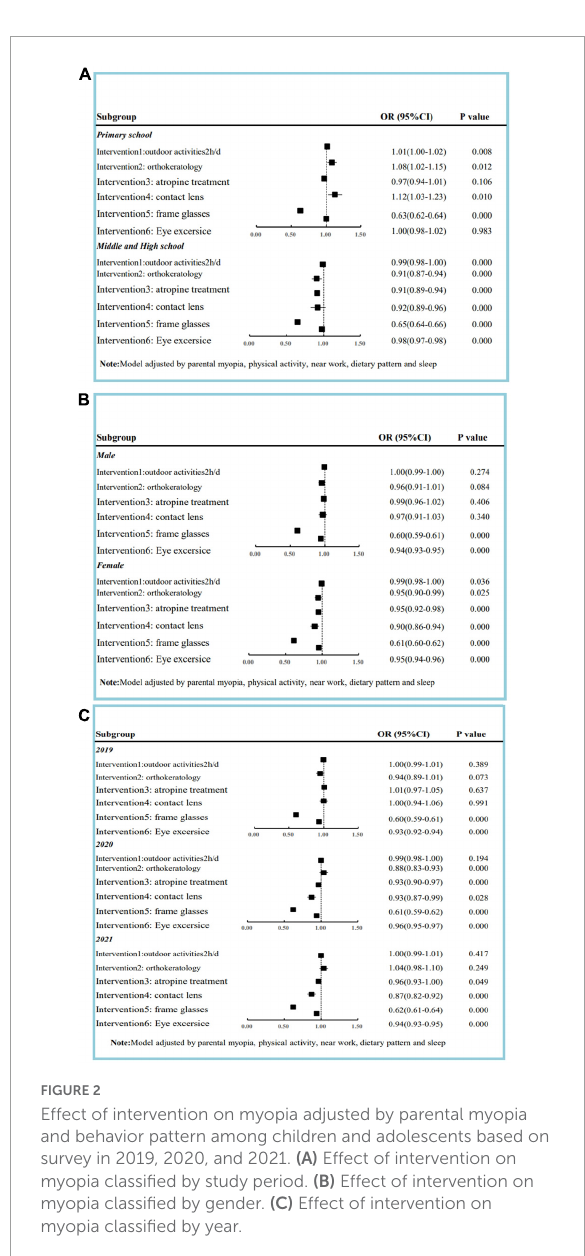
FIGURE2 Effect of intervention on myopia adjusted by parental myopia and behavior pattern among children and adolescents based on survey in 2019, 2020, and 2021. (A) Effect of intervention on myopia classified by study period. (B) Effect of intervention on myopia classified by gender. (C) Effect of intervention on myopia classified by